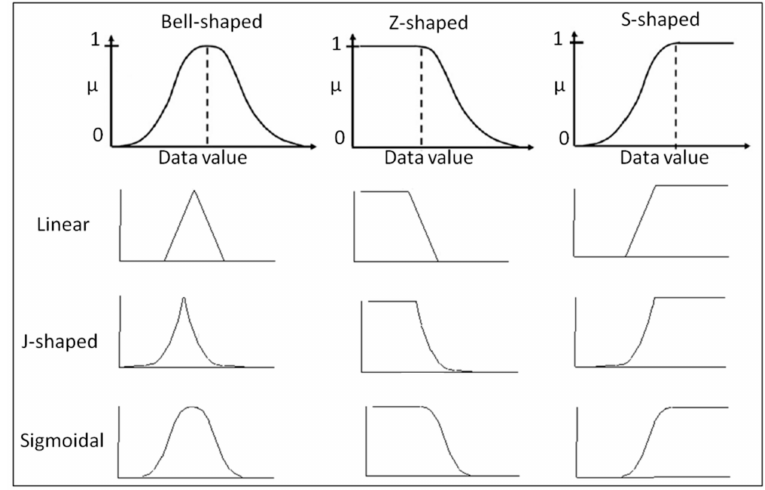
Figure 5. Basic curves of fuzzy set membership functions µ . Modified from